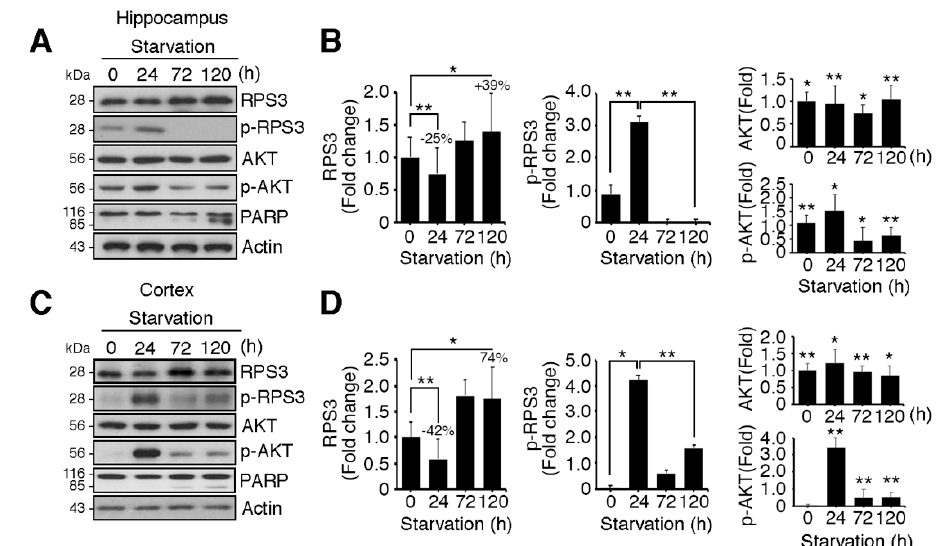
Figure 1. Ribosomal protein S3 (RPS3) is highly upregulated in the hippocampus and cerebral cortex after starvation. C57BL/6 mice were subjected to nutrient starvation, with only water supplied, for 0, 24, 72, and 120 h and were euthanized to isolate the hippocampal area and cortical area of the brains. Endogenous protein levels of RPS3 or phospho (p)-RPS3 in the ( A ) hippocampus or ( C ) cortex were measured by immunoblotting with anti-RPS3 and anti-p-RPS3 antibodies, and neuronal apoptosis was evaluated with an anti-poly-ADP-ribose polymerase (PARP) antibody. ( B , D ) RPS3/p-RPS3 (left), AKT/p-AKT (right) protein levels were determined by densitometric analysis in ( B ) the hippocampus or ( D ) cortex. Densities of immunoblotting were measured with Image J and its normalized with control mice (0 h) brain lysates. Values in this figure represent the mean ± SEM from three independent experiments, and the images shown are representative of at least three independent experiments. Statistical significance was calculated using a one-way ANOVA test followed by Turkey’s post-test (* p < 0.01; ** p < 0.001).